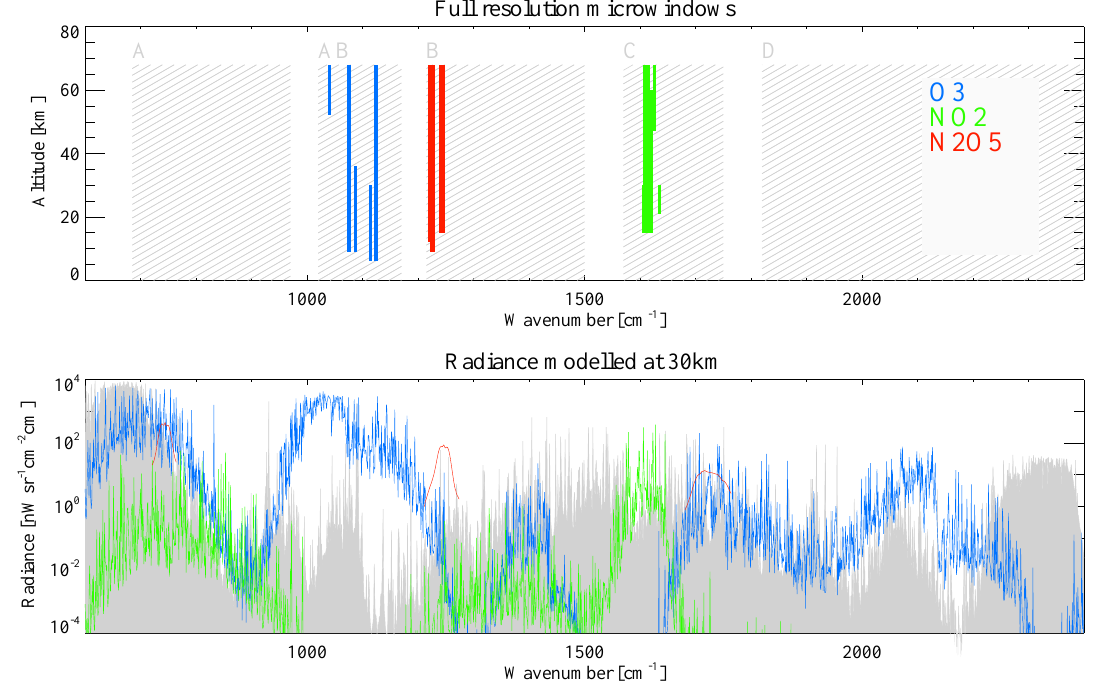
Fig. 1. Top panel shows the spectral regions used to retrieve N 2 O 5 in red, NO 2 in green and ozone in blue. Grey shaded area in the top panel shows the spectral coverage of MIPAS-ENVISAT. Bottom panel shows the contribution to modelled limb radiance at 30km for each species for a standard atmosphere. Contribution of other molecules (mainly water vapour and CO 2 ) shown in